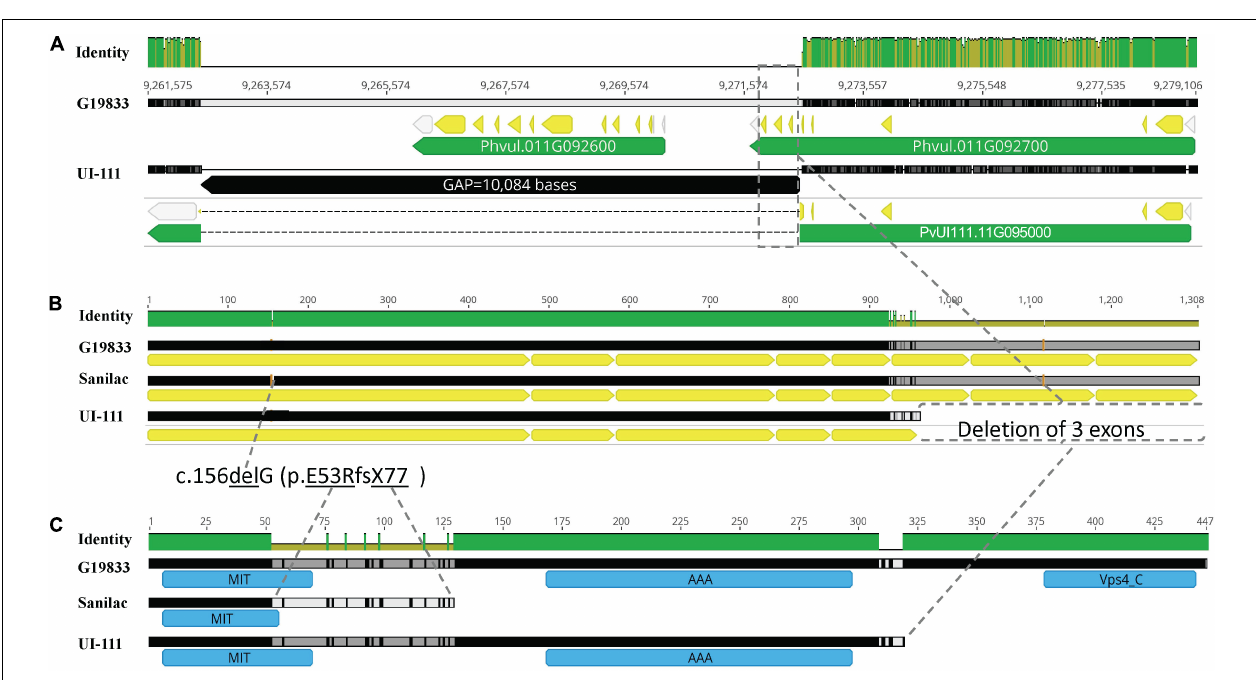
FIGURE 2 | Genomic and protein representation of the candidate gene ( Phvul.011G092700 gene in G19833 v2.1 is synonymous with PvUI111.11G095000 gene in UI 111 v1) for bc-2 . (A) Candidate gene comparison between G19833 and UI 111 reference genomes depicting a deletion in the 3 (cid:48) region of the candidate gene PvUI111.11G095000 (perpendicular rectangular box outlined by dashed line). (B) The Coding Sequence (CDS) of Phvul.011G092700 gene model in a reverse alignment of G19833 (wild-type Bc-2 ), Sanilac ( bc-2 [ Robust ] ), and UI 111 ( bc-2 [ UI 111 ] ) genotypes. (C) Protein prediction in silico of Phvul.011G092700 in G19833, Sanilac, and UI